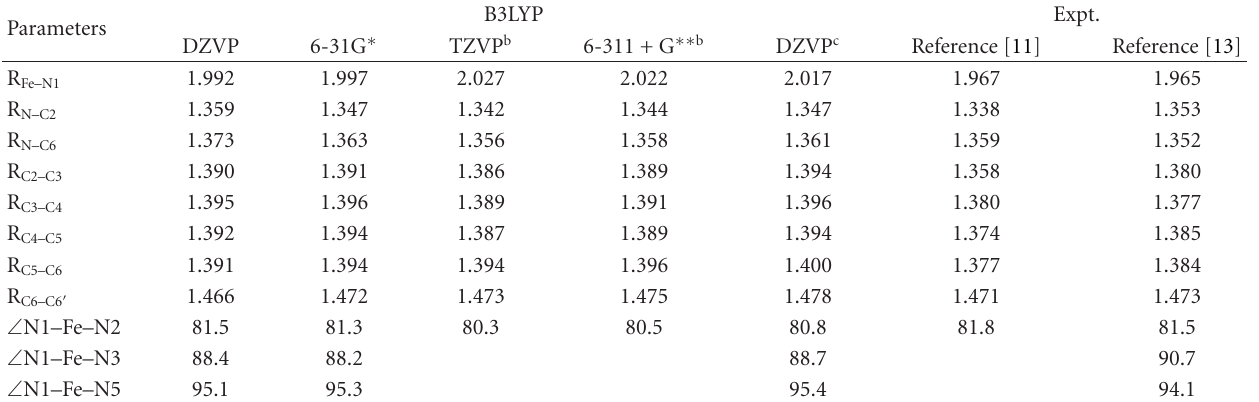
Table 1: Comparisons between calculated geometrical parameters of the [FeL 3 ] 2+ using B3LYP at di ff erent basis sets in the gas phase with experimental values a